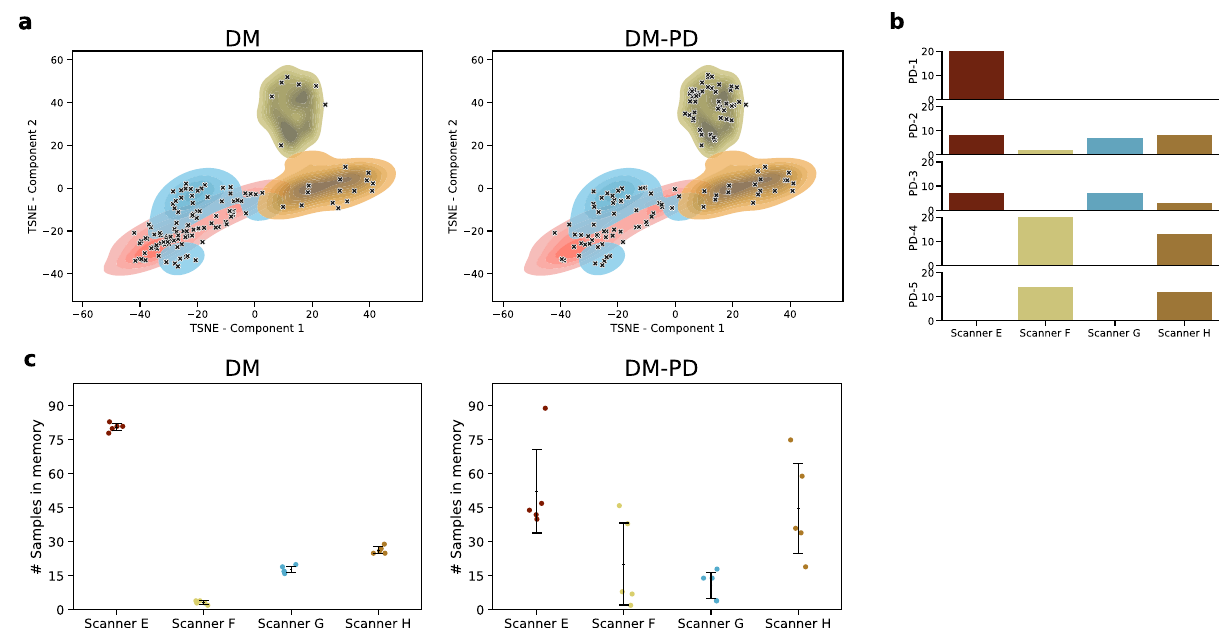
Fig. 6 Enhancing memory diversity. Comparison of memory composition for DM vs. DM-PD for M = 128. a TSNE over the Gram matrices of the training set shows a distinction of the domains. Markers show positions of memory elements at the end of training for one run. DM-PD shows a more equal distribution over the whole training set. b Five pseudo-domains detected were detected for a single training run of DM-PD; bars show the amount of domain elements assigned to the pseudo-domains. c Amount of domain elements in memory after training for DM and DM-PD. Error bars represent standard deviation and mean (middle line), n = 5 independent